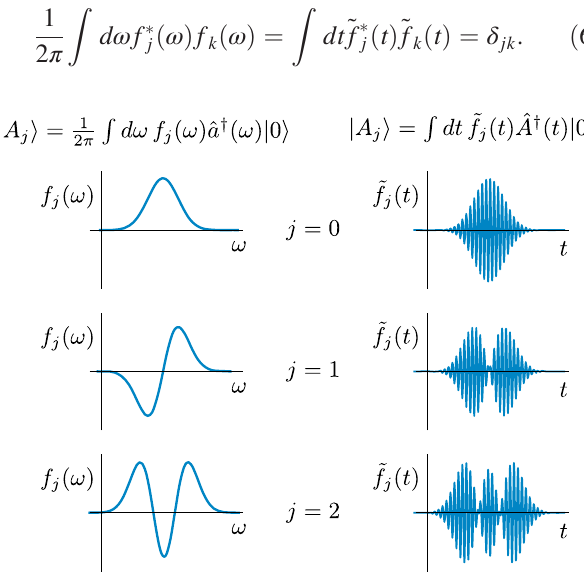
FIG. 1. First three members of a TM basis in the frequency domain (left) and the time domain (right).